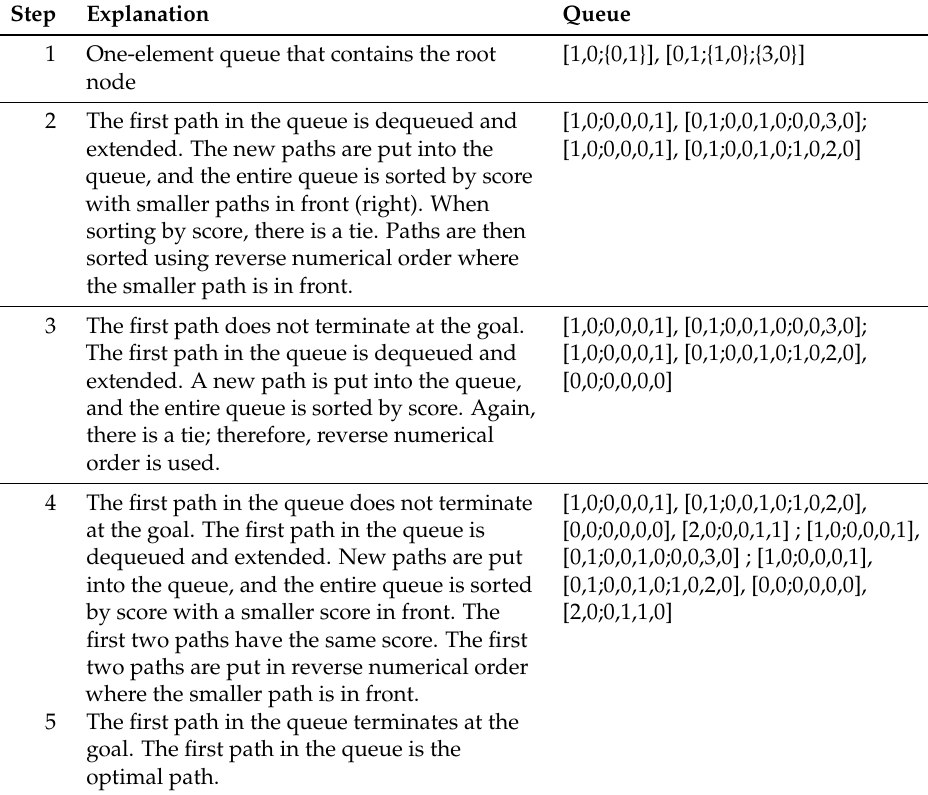
Figure 3. Branch and bound with an admissible heuristic (as an implementation detail, we assume that we do not start from the goal and there exists a path to the goal). Table 2. Optimal space extension for the classical quartic anharmonic oscillator ODE set using branch and bound with an admissible